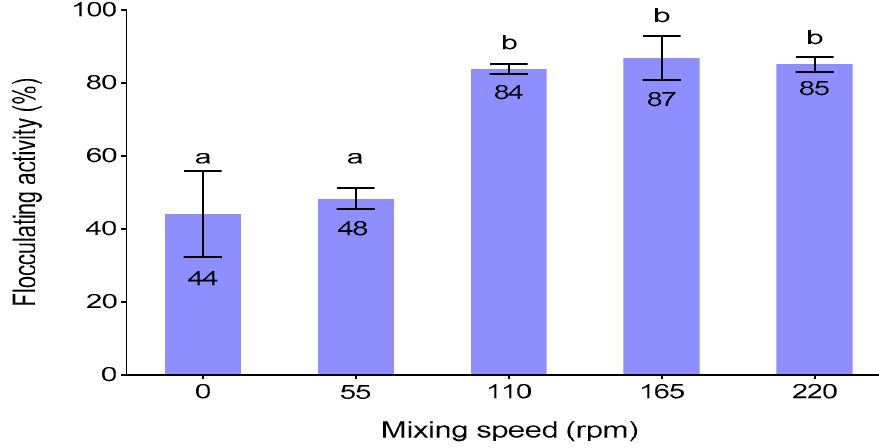
Figure 1. E ff ect of shaking speed on flocculating activity di ff erent letters (a & b) denotes statistical Figure 1. Effect of shaking speed on flocculating activity d ifferent letters (a & b) denotes significance at ( p <